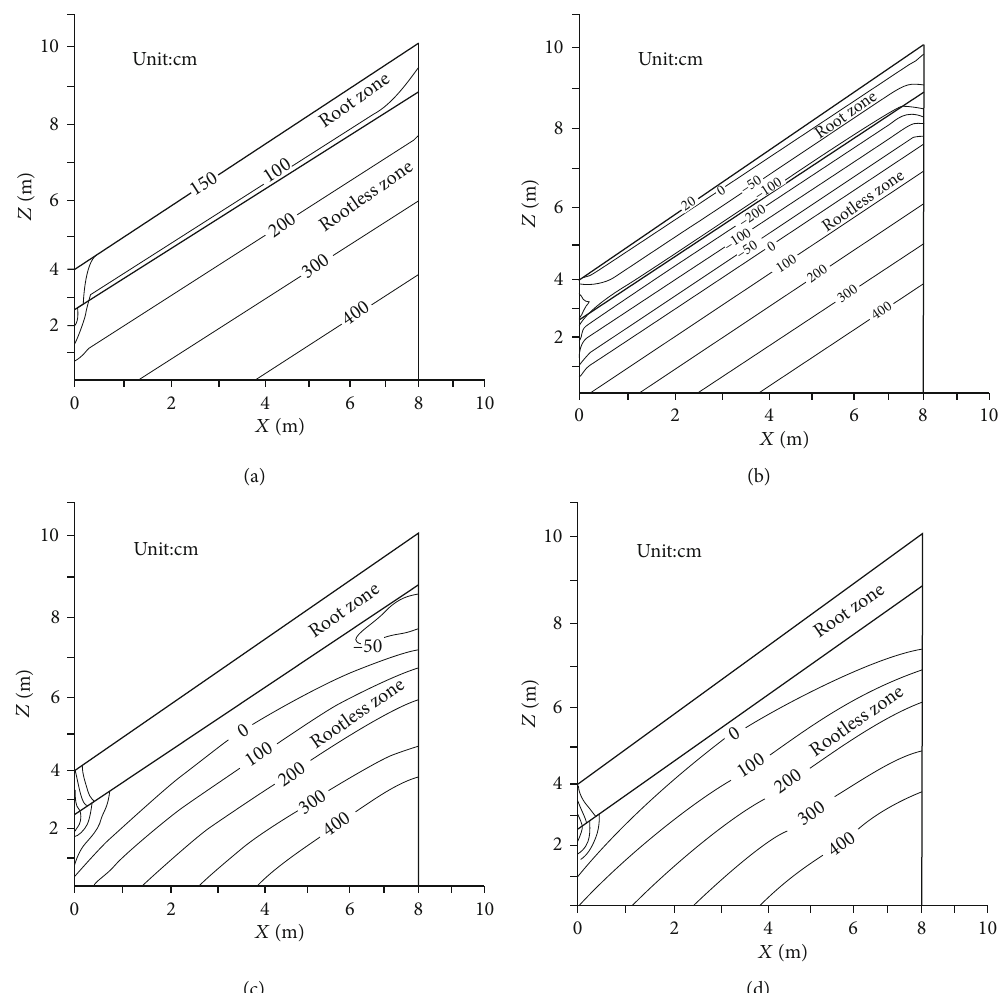
Figure 8: Pressure head distributed on the uniform roots for rainfall duration of 60 h with rainfall amount of 500 mm: (a) drying 12 h, (b) rainfall 12, (c) rainfall 36, and (d) rainfall 60